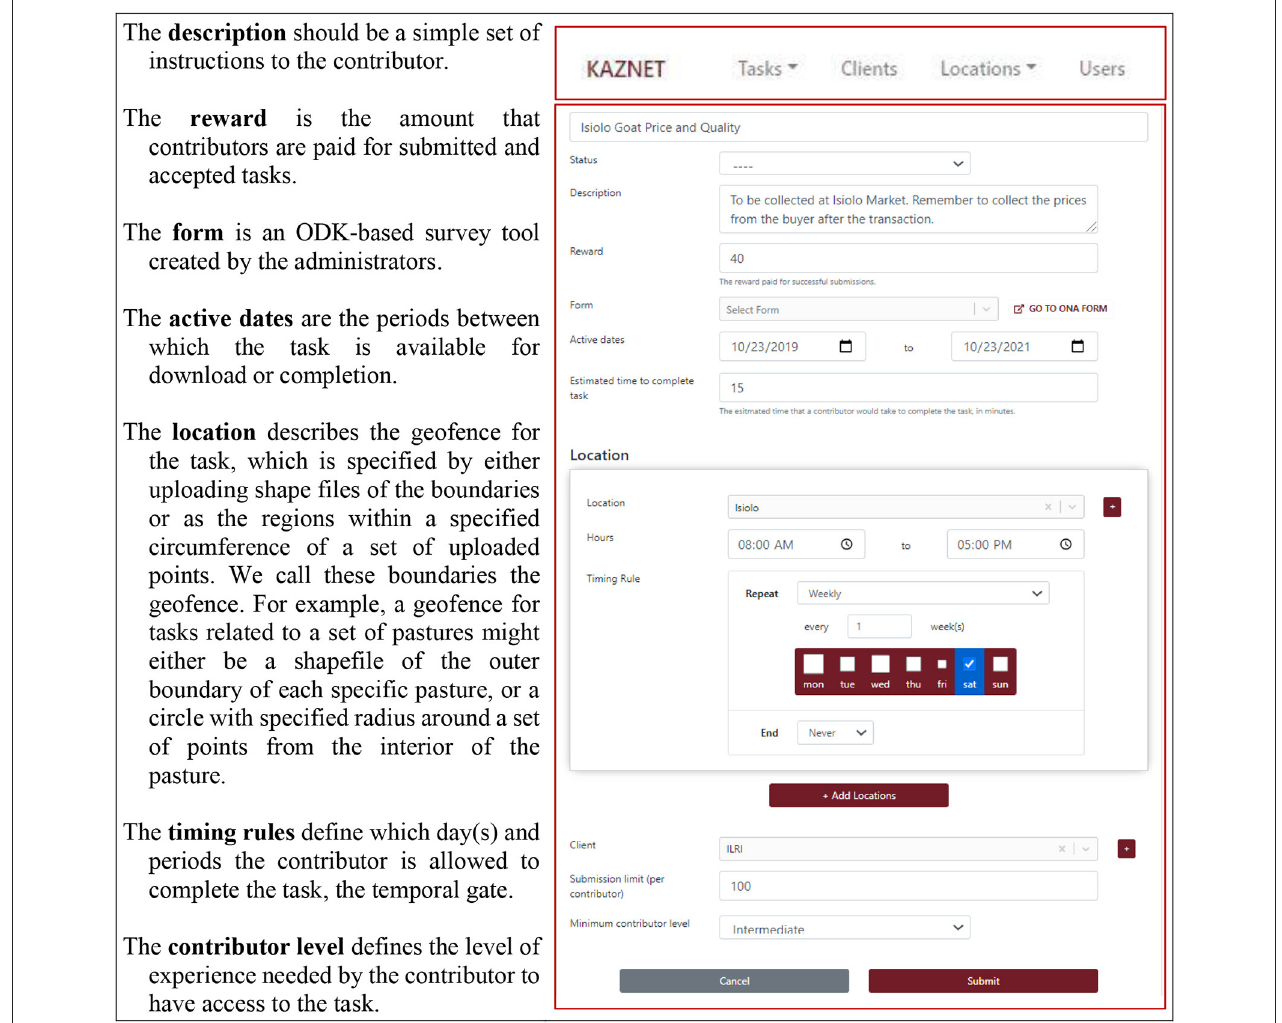
FIGURE 2 | The KAZNET web application is used to define task